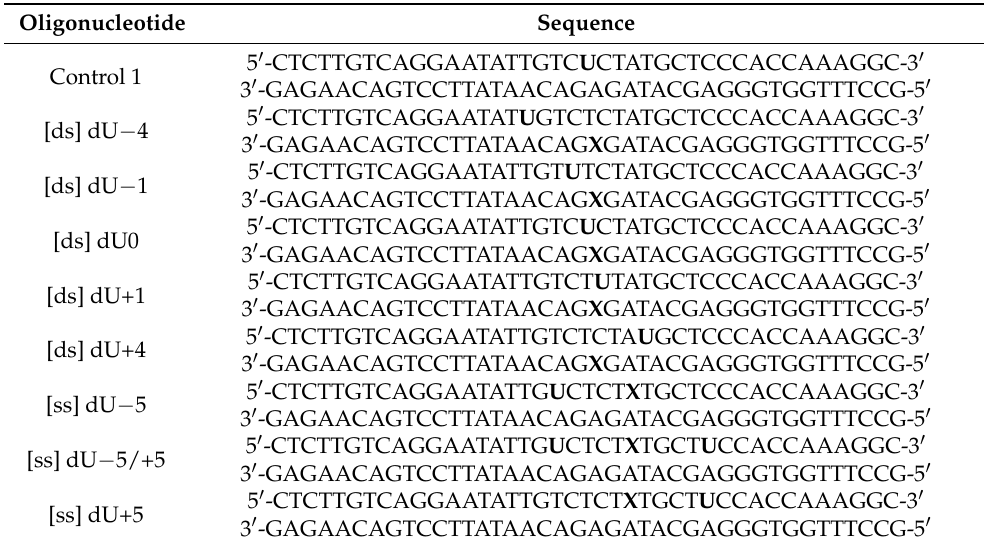
Table 1. The list of substrate ds-oligonucleotides containing 2 (cid:48) -deoxyuridine (dU) and 5 (cid:48) ,8-cyclo-2 (cid:48) - deoxyadenosine